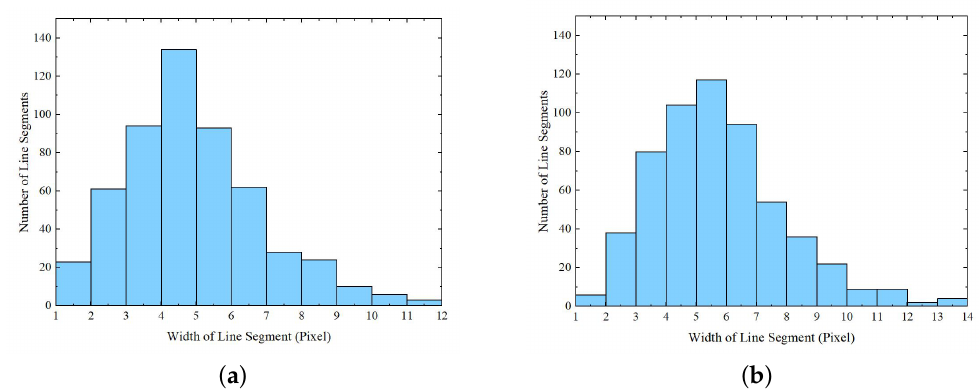
Figure 12. Statistics on line segment width. ( a ) With strength information. ( b ) Without strength information.